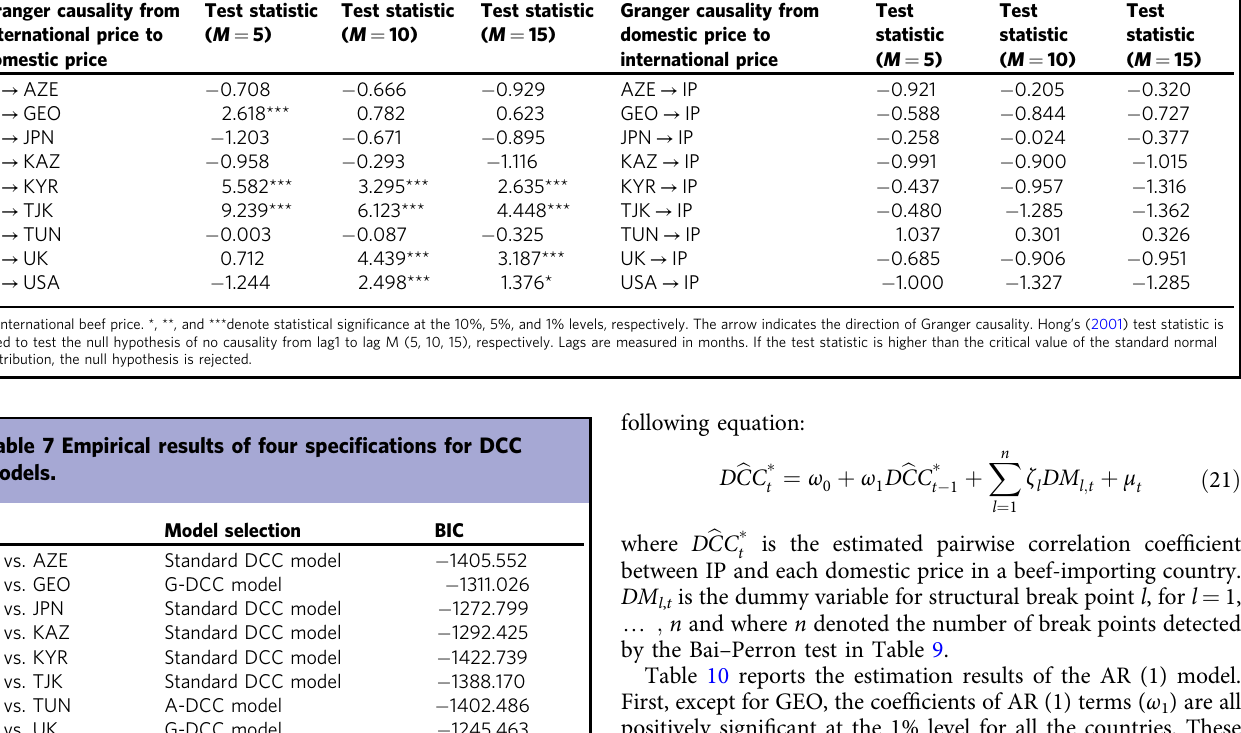
Table 6 Empirical results for Granger causality-in-variance test. Granger causality from international price to domestic